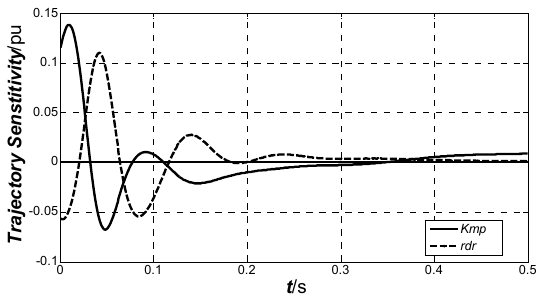
Figure 7. The trajectory sensitivity of parameter mp K and dr r . Table 3. Parameter estimated value.